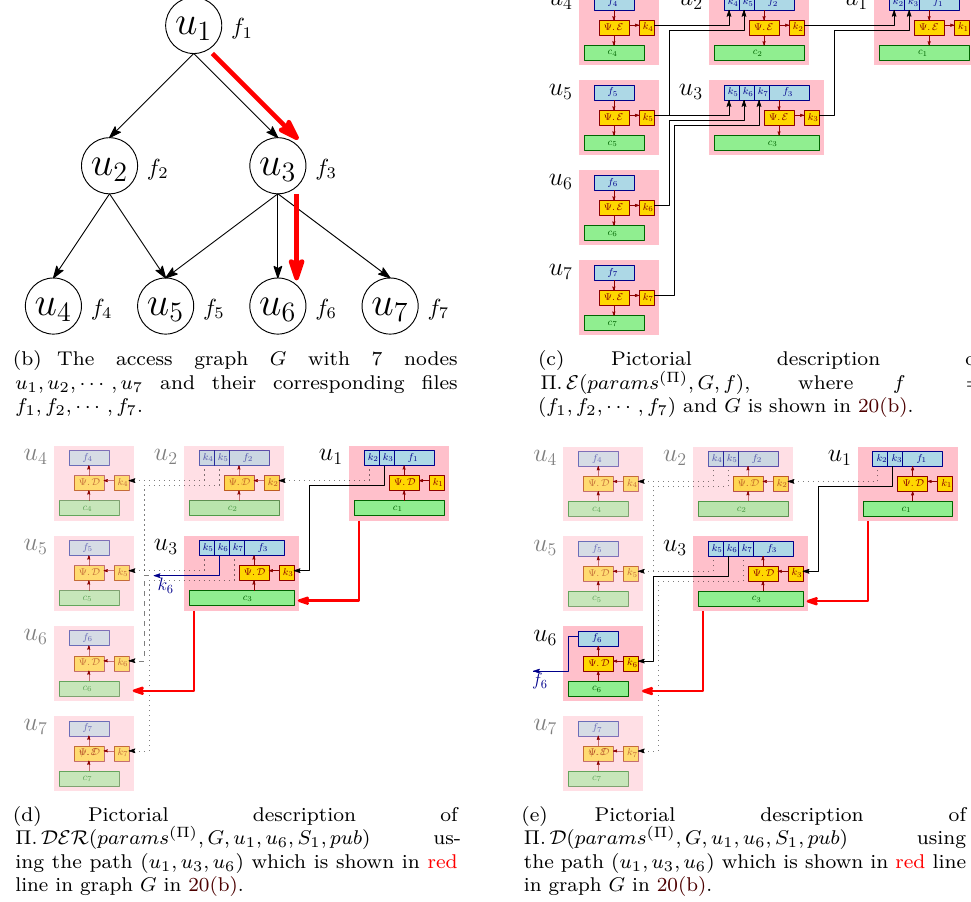
Figure 20: Building Construction 1